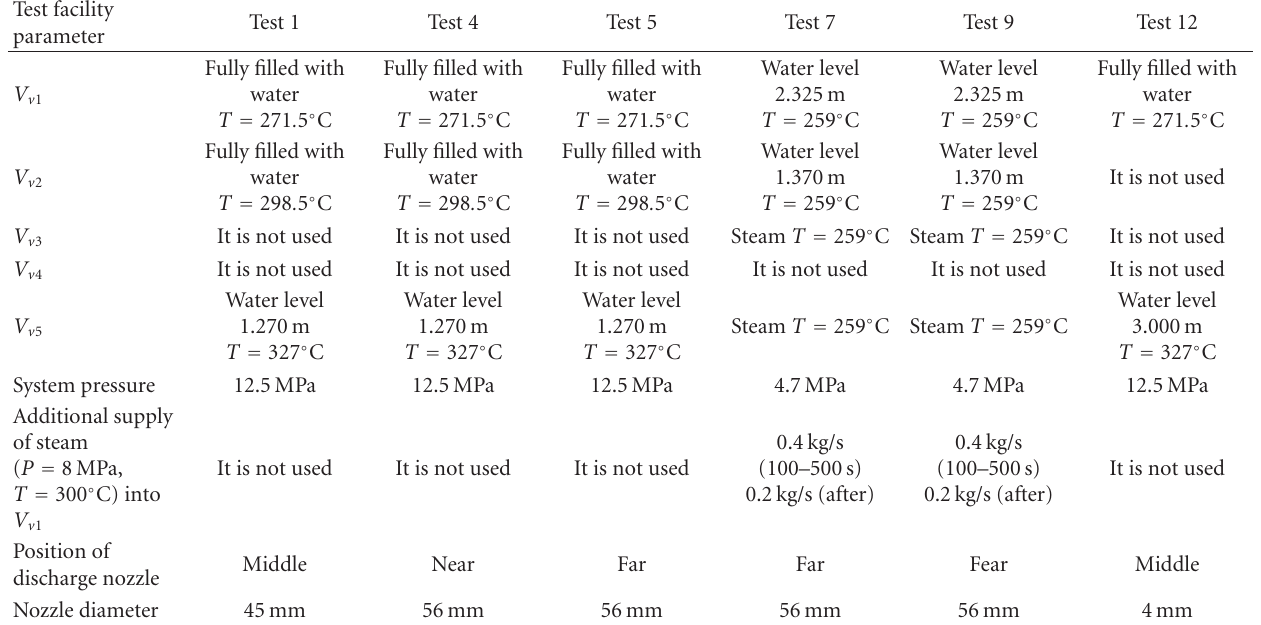
Table 6: Initial and boundary conditions of the tests.